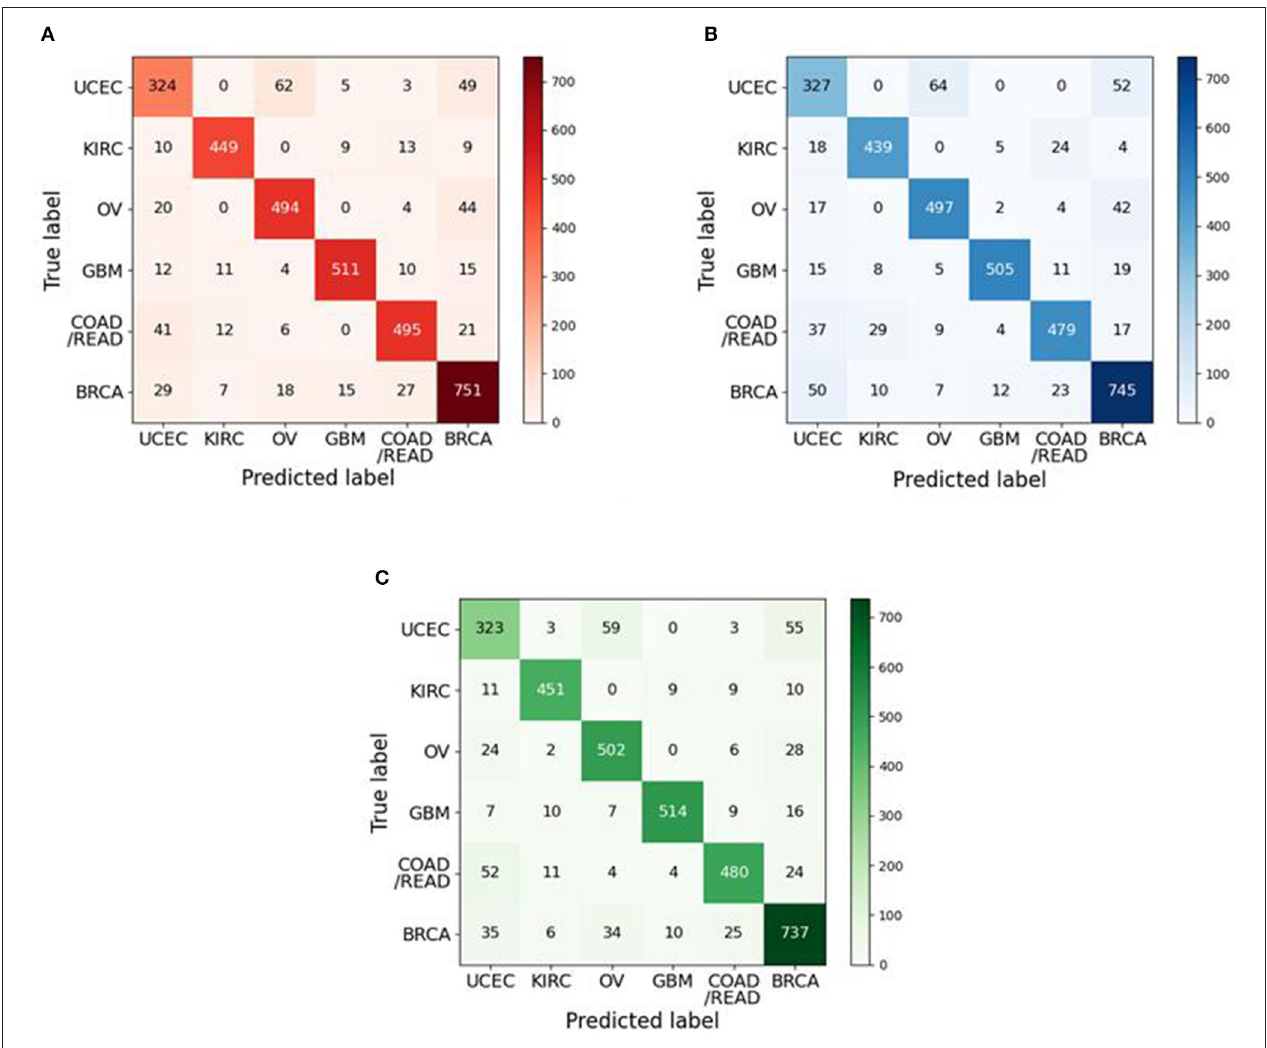
FIGURE 4 | Confusion matrices on the test groups: (A) CRIA_CatBoost; (B) CRIA_SVM; (C) CRIA_LightGBM.